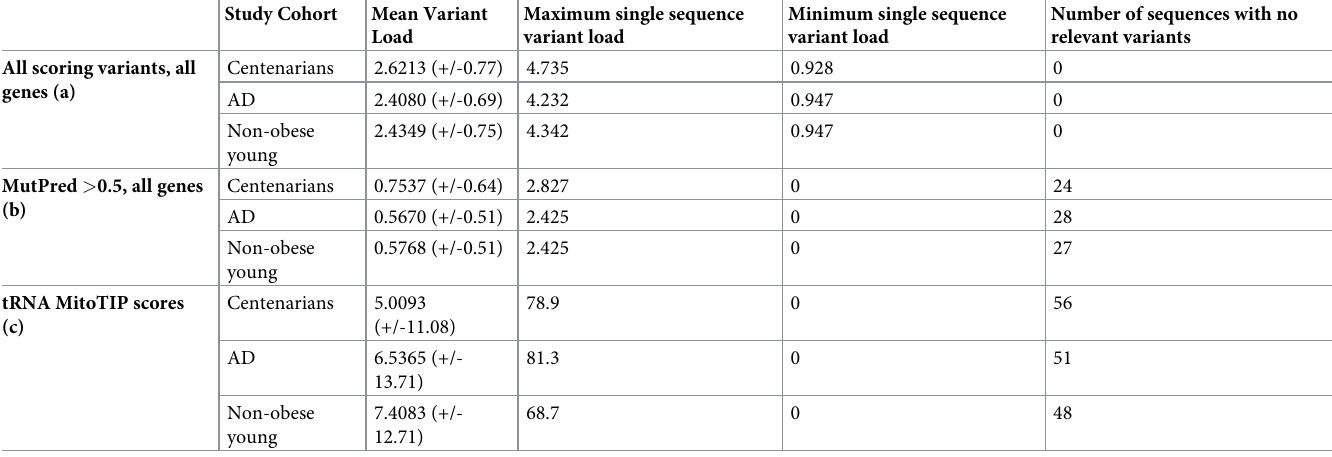
Table 1. Mean variant loads (with standard deviations) for Japanese centenarian, AD patient and healthy young cohorts, calculated using: (a) all MutPred scoring variants, (b)variants scoring > 0.5 on MutPred and (c) MitoTIP tRNA variant